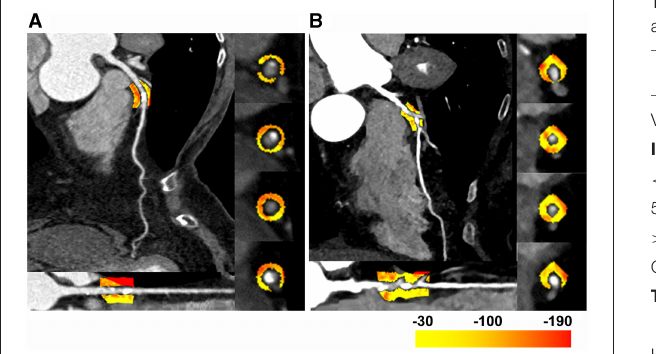
TABLE 2 | The comparison of plaque characteristics and lesion-specified fat attenuation index (FAI lesion ) in different lesions. Total FFR < 0.8